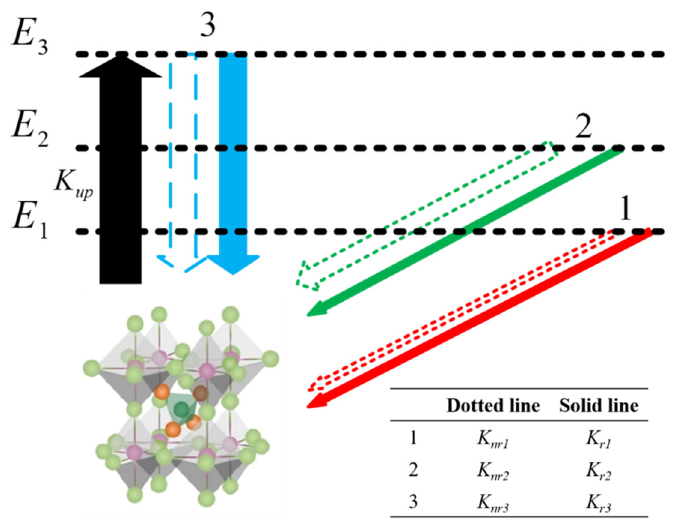
Figure 5. Schematic illustration of charge separation excitons in different states. To obtain more information, the percentage of each exciton state in the PL was calcu- lated according to Equation (7) and the above fitting parameters. As shown in Figure 6a, more than 99% of the excitons were located in the E 1 state from 78 to 300 K. With the increase in temperature from 300 to 500 K, the exciton percentages of E 2 and E 3 states increased rapidly (for example, at 330 K, the exciton percentages of E 1 , E 2 , and E 3 states were 98%, 1.8%, and 1.2%, respectively). At 430 K, they were 88.3%, 9.7%, and 2%, re- spectively. The percentage of excitons in the E 2 state increased by almost 5 times). In the range of 78 to 250 K, most of the light emission came from the recombination of the E 1 state excitons, which caused the PL intensity to change slightly with the temperature. With increasing temperature, the percentage of the E 1 exciton decreased slightly from 300 to 500 K. Although the radiative recombination rate of the E 3 state was about 64 times that of the E 1 state, the non-radiative rate was about 66 times greater, so it did not lead to an increase in PL intensity. As the temperature increased from 400 to 500 K, the percentage of E 1 -state excitons decreased rapidly, while the proportion of E 2 - and E 3 -state excitons increased rapidly. This trend slowed down as the temperature neared 500 K, which may have been due to the increase in non-radiative transition caused by lattice vibration and lattice relaxation of luminescence center due to the temperature being too high [27].